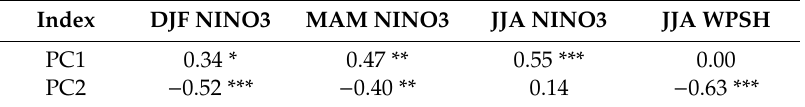
Table 2. The linear correlation coe ffi cients between PC time series and the winter (DJF), spring (MAM), and summer (JJA) NINO3 indices, and JJA western Pacific subtropical high index (WPSHI). *, ** and *** indicate statistical significance at the 90%, 95% and 99% confidence levels on a Student’s t-test, respectively. Note that DJF and MAM are prior